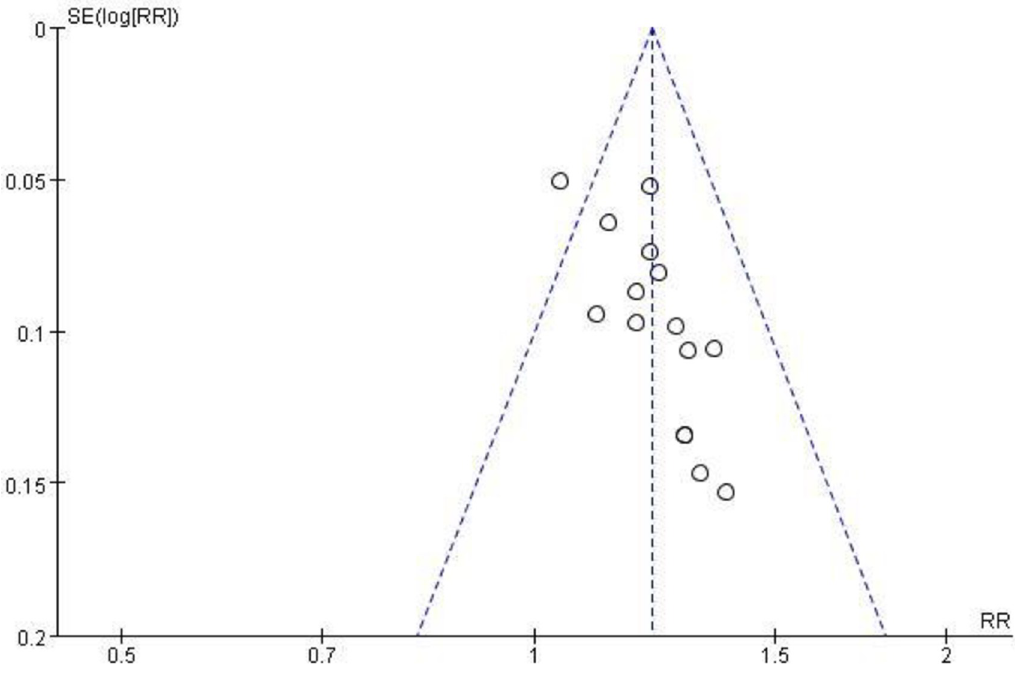
Fig 10. Inverted funnel plots of effective